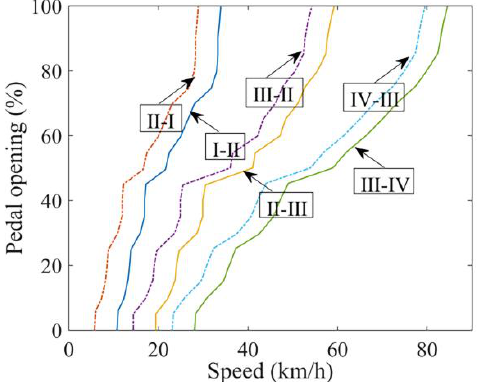
Figure 4. The efficiency surface of each gear.